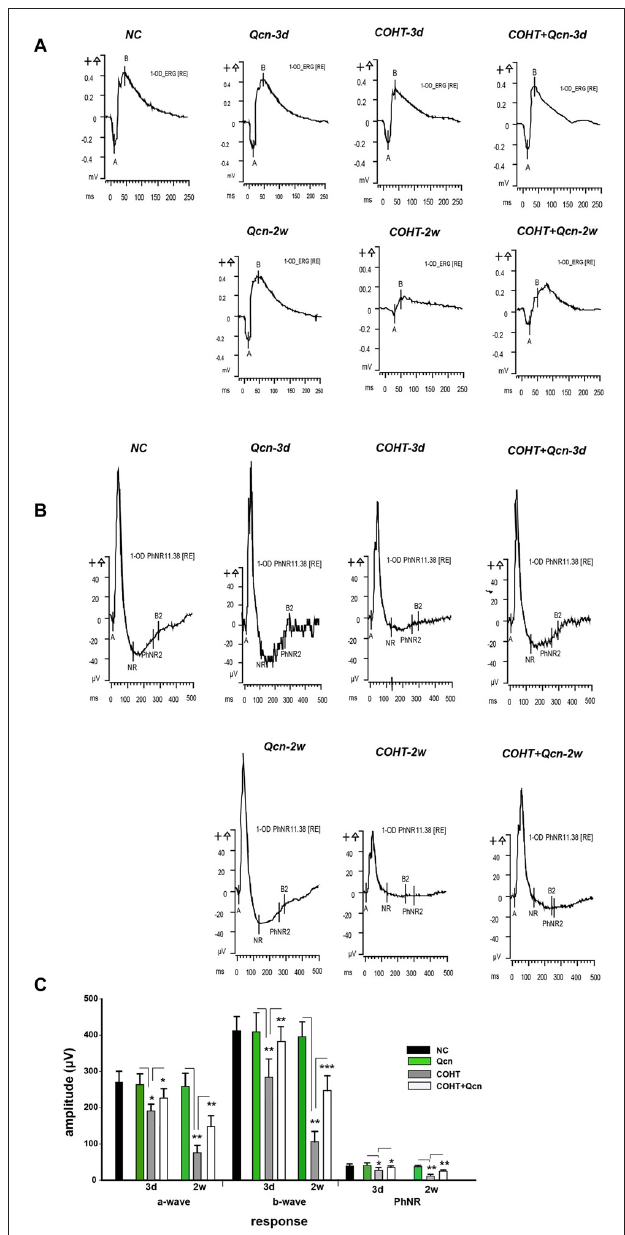
FIGURE 2 | Effects of Qcn on electroretinography (ERG) and Photopic Negative Response (PhNR) responses. (A) Representative ERG at baseline, 3 days and 2 weeks of COHT with or without Qcn. (B) Data analyses of ERG a-wave, b-wave and PhNR amplitudes for the NC, Qcn, COHT and COHT+Qcn groups after 3 days and 2 weeks of microbead injection. (C) PhNR amplitudes at baseline, 3 days and 2 weeks of COHT with or without Qcn. The data are expressed as the mean ± SD, ∗ p < 0.05, ∗∗ p < 0.01 and ∗∗∗ p < 0.001 for the COHT group compared with the NC group and COHT+Qcn group compared with the COHT